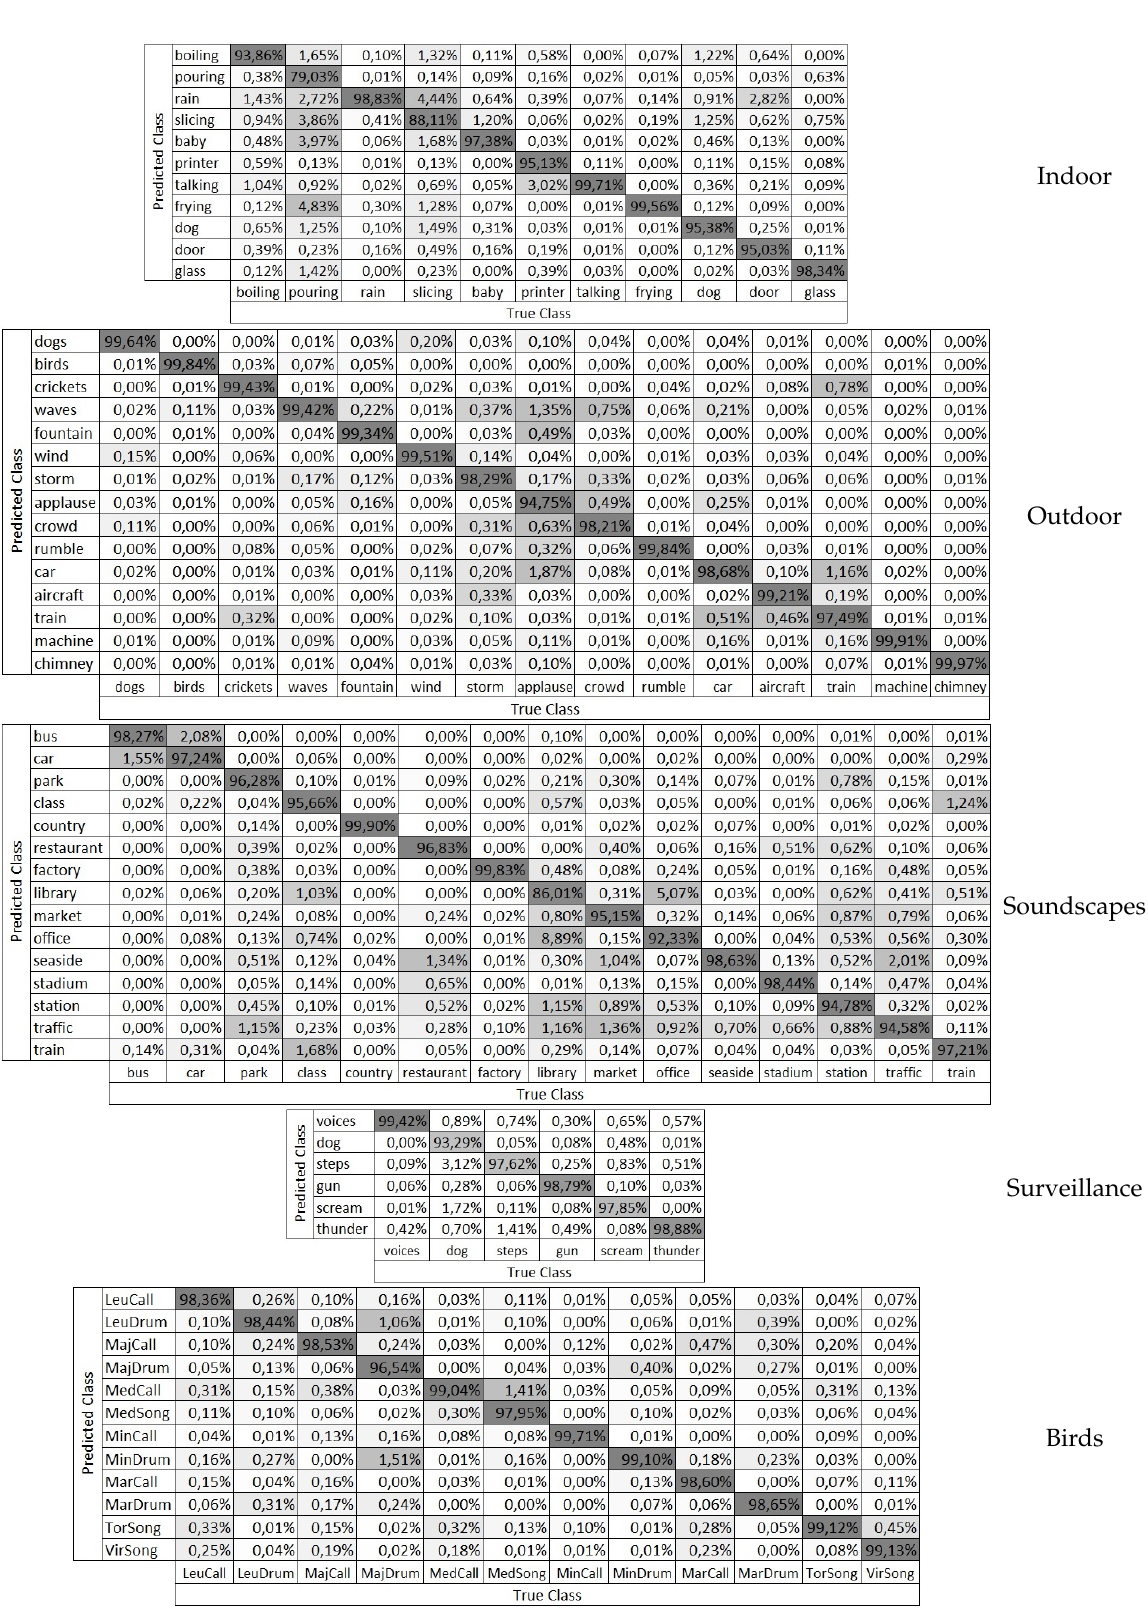
Figure 5. Confusion matrices of the optimum setting (Gammatone Cepstrum Coefficients (GTCC)+kNN) in the analyzed corpora